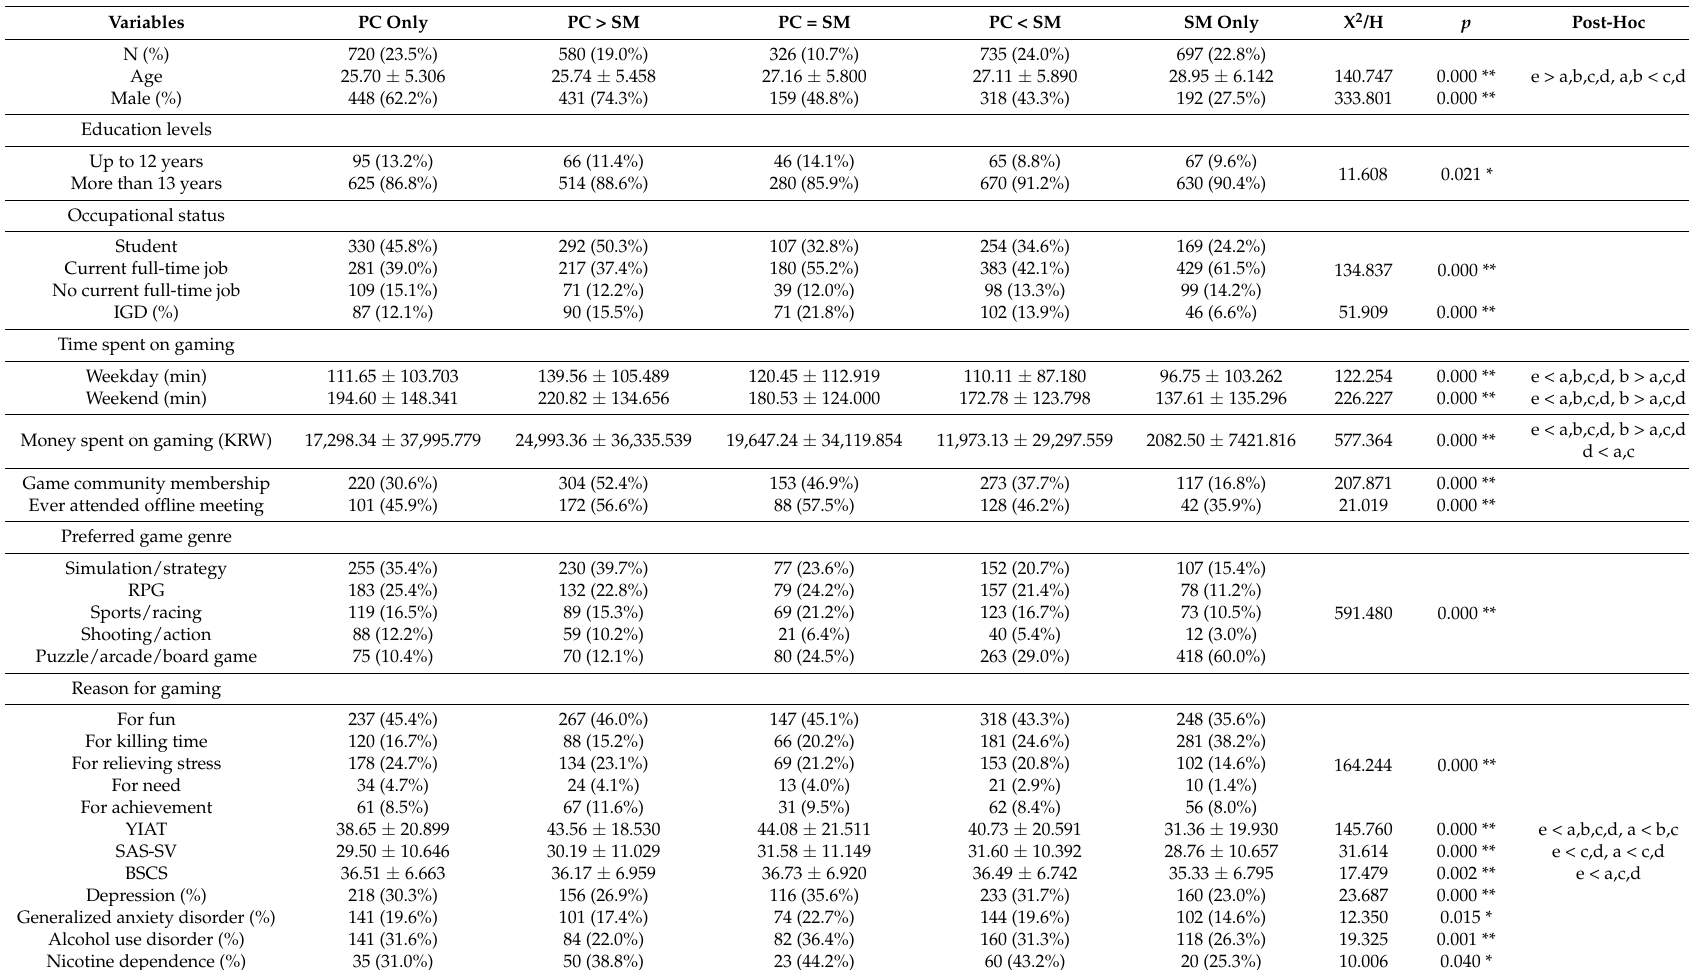
Table 2. Differences across device usage